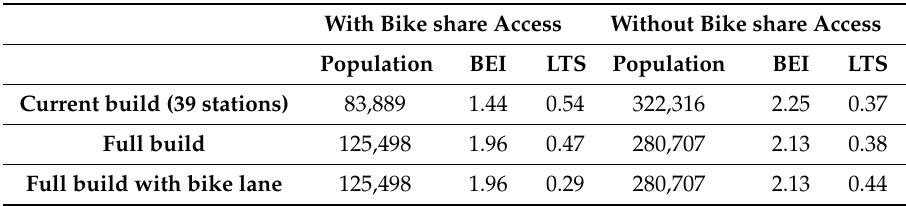
Table 2. Average Bike Equity Index (BEI)-Density and Level of Traffic Stress (LTS) Score for Individuals with and without Access to Bike share.